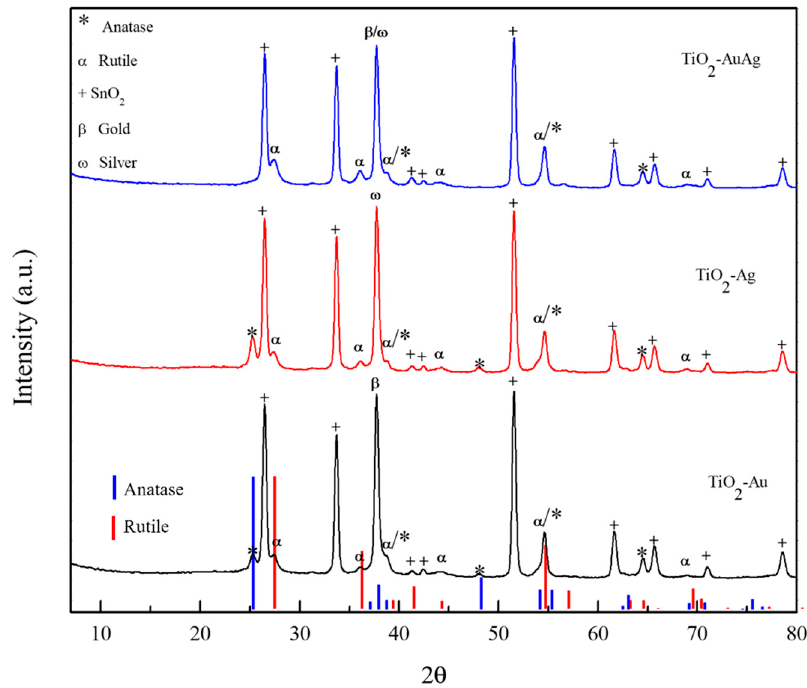
Figure 2. X-ray diffraction patterns of Au, Ag and AuAg-TiO 2 thin films. The Williamson–Hall (W–H) method was used to calculate the crystallite size [38,39]. Figure 3 shows graphs of β Cos θ vs. Sin θ obtained by applying the proposed method. The average values of the Au, Ag, and Au-Ag crystallite size, determined from the intercept values (K λ /D), were 20, 17, and 17 nm, respectively.